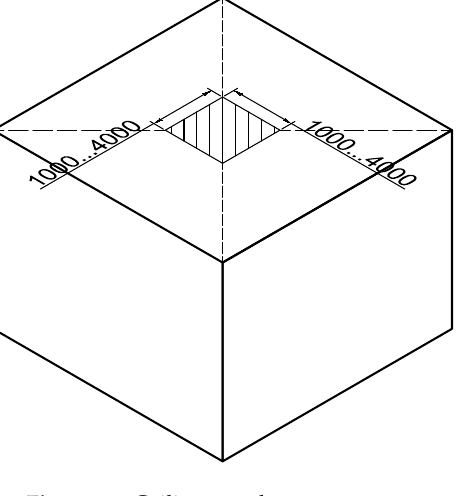
Figure 18. Ceiling panel—square setup.